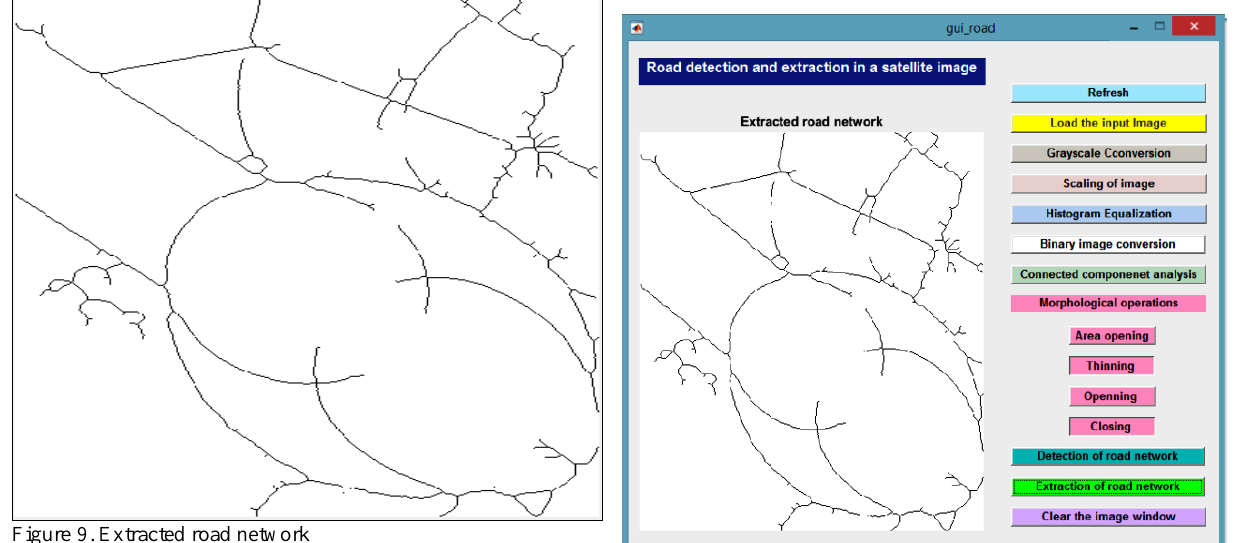
Figure 10. GUI developed in